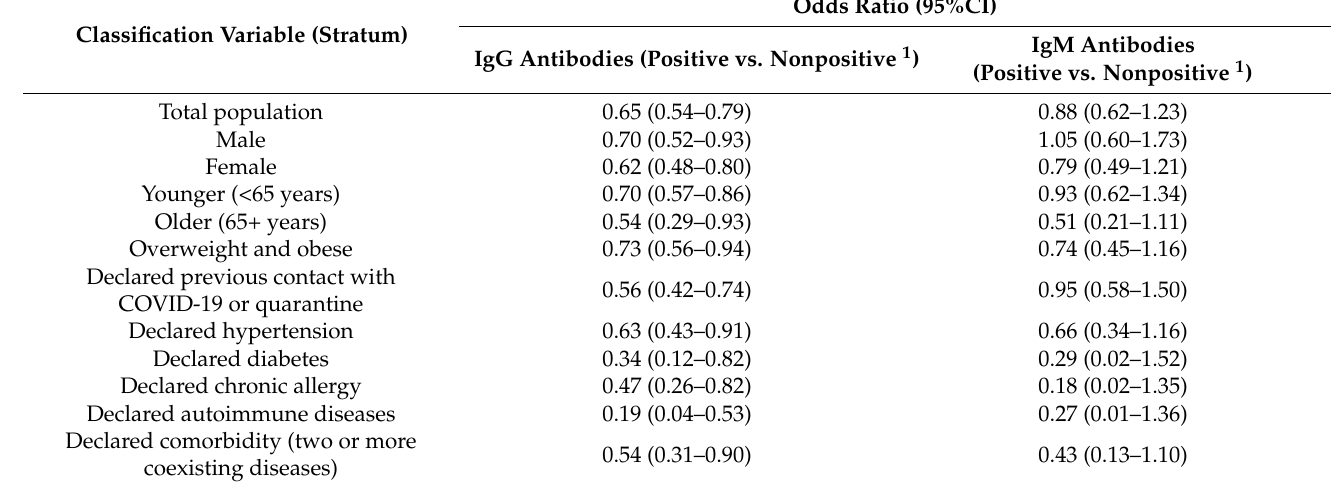
Table 3. Crude odds ratio and its 95% confidence interval (CI) for the relationship between seasonal influenza vaccination (“Yes” vs. “No or I Do Not Know”) and the results of the SARS-CoV-2 IgG and IgM tests.